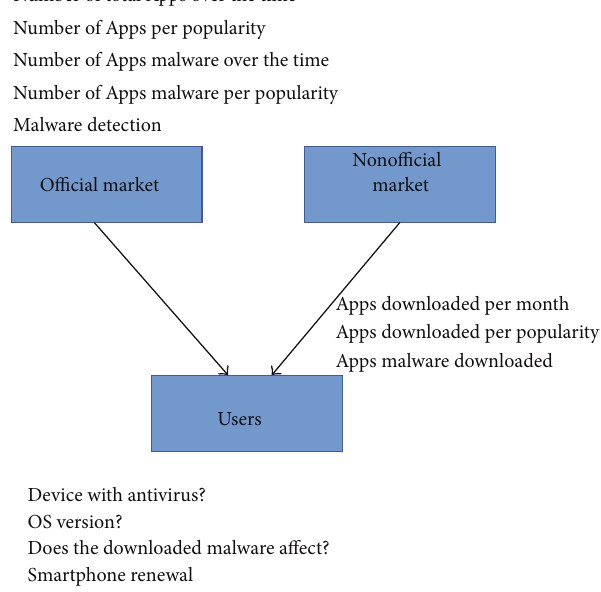
Figure 1: General structure of the agent-based model. Issues we are going to take into account in the modelling